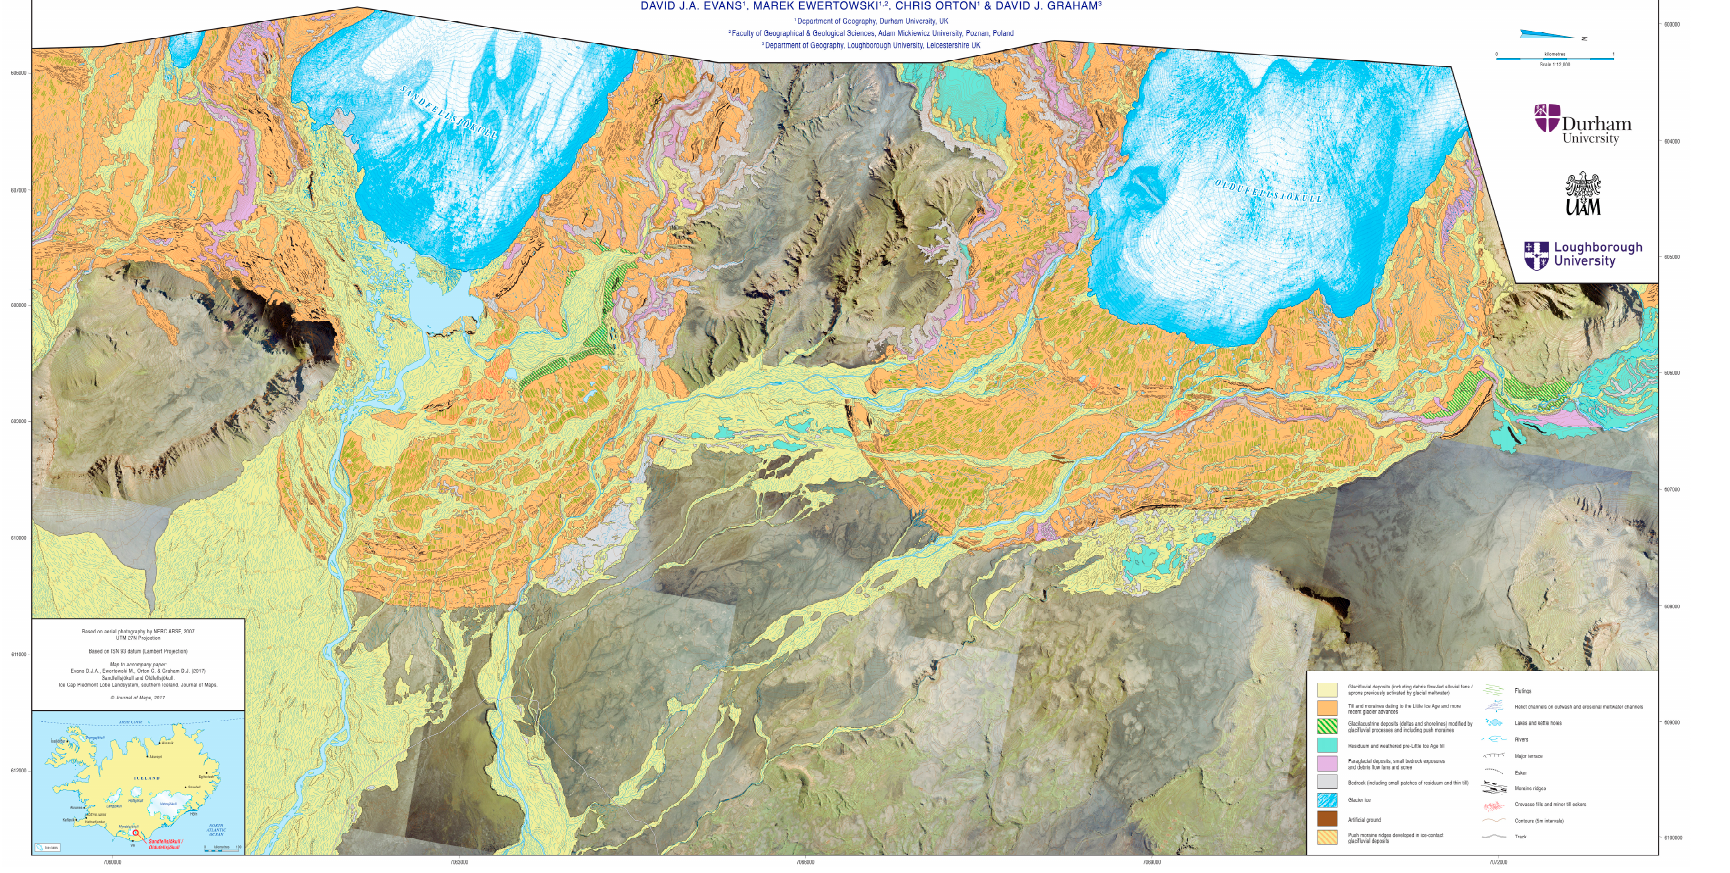
Figure 6. Surficial geology and glacial geomorphology map of the East Mýrdalsjökull outlets Sandfellsjökull and Oldufellsjökull. A larger format version of this map is available in Supplementary Information where it can be downloaded and printed at a recommended A0 paper size (Supplementary Materials Figure S1).